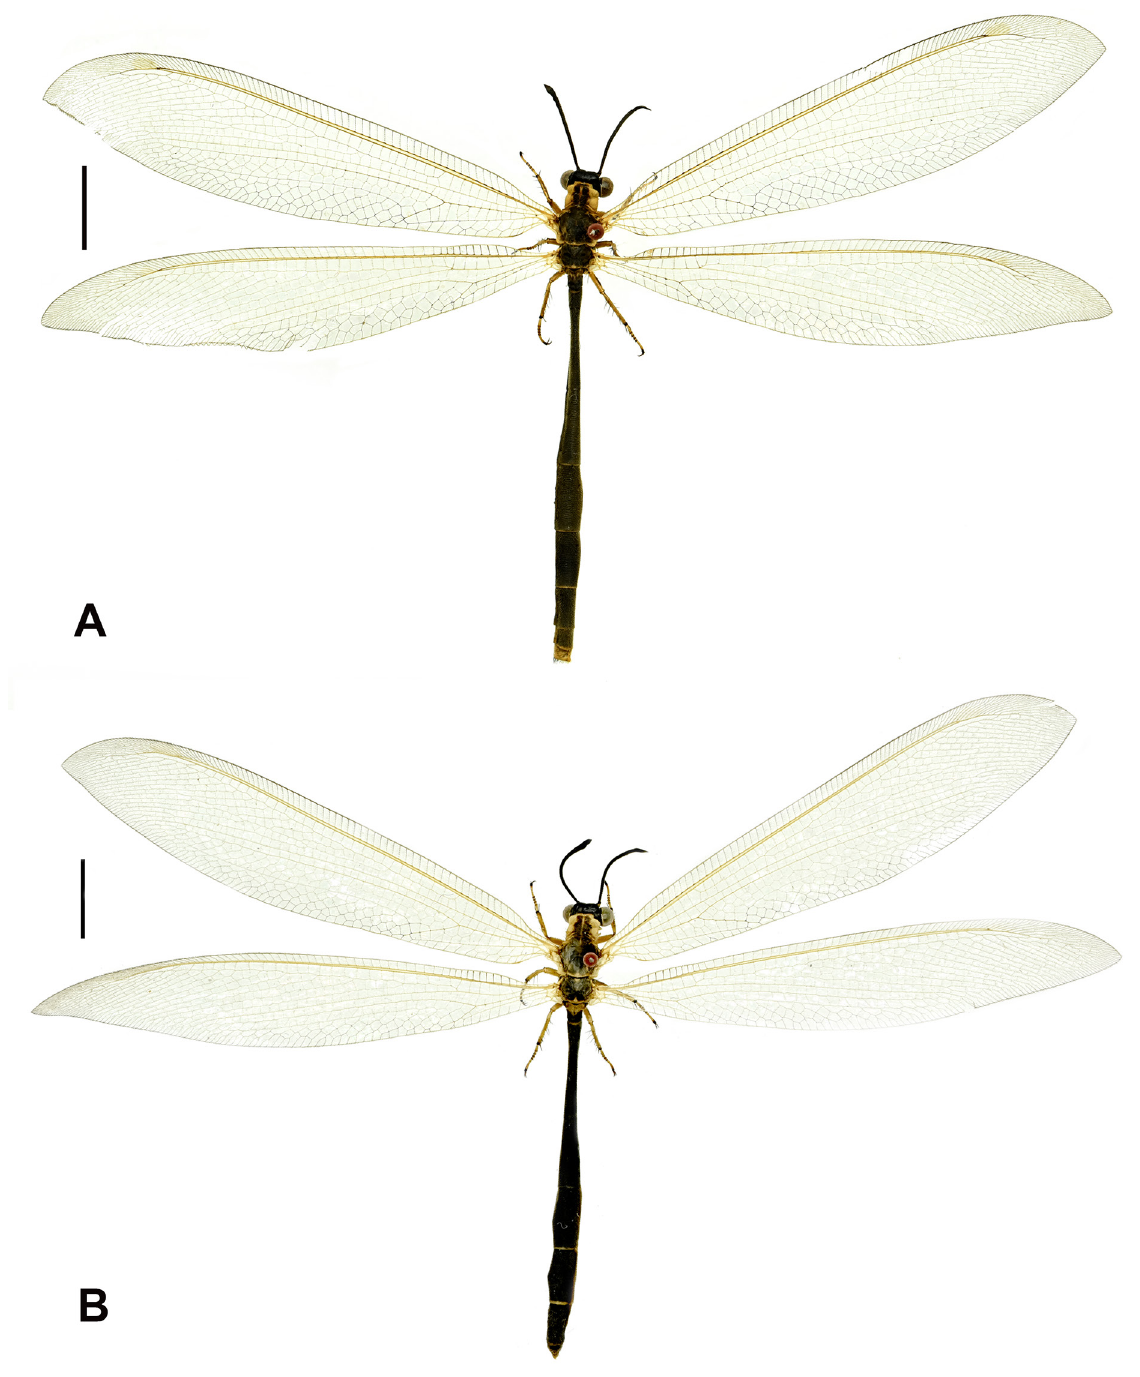
Fig. 16. Myrmeleon trivialis Gerstaecker, 1885. Dorsal habitus. A . Male (CAUPK000025). B . Female (CAUPK000026). Scale bars = 5.0